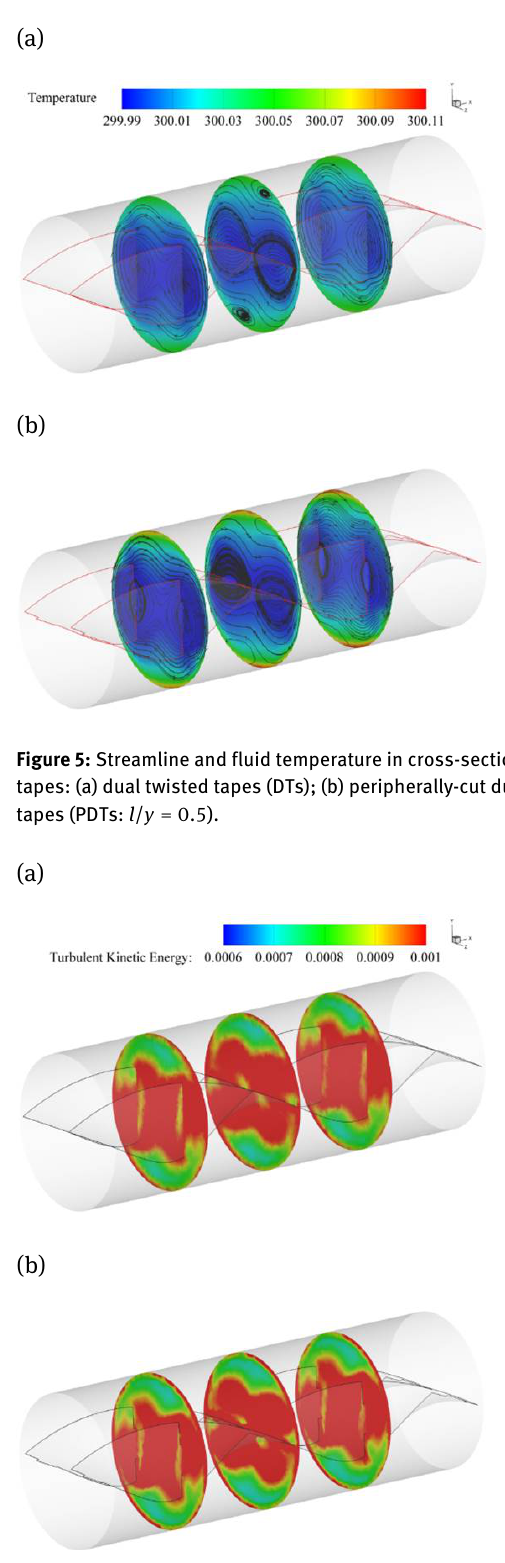
Figure 6: Turbulent kinetic energy (TKE) in cross-section view of tapes: (a) dual twisted tapes (DTs); (b) peripherally-cut dual twisted tapes (PDTs: l / y = 0.5